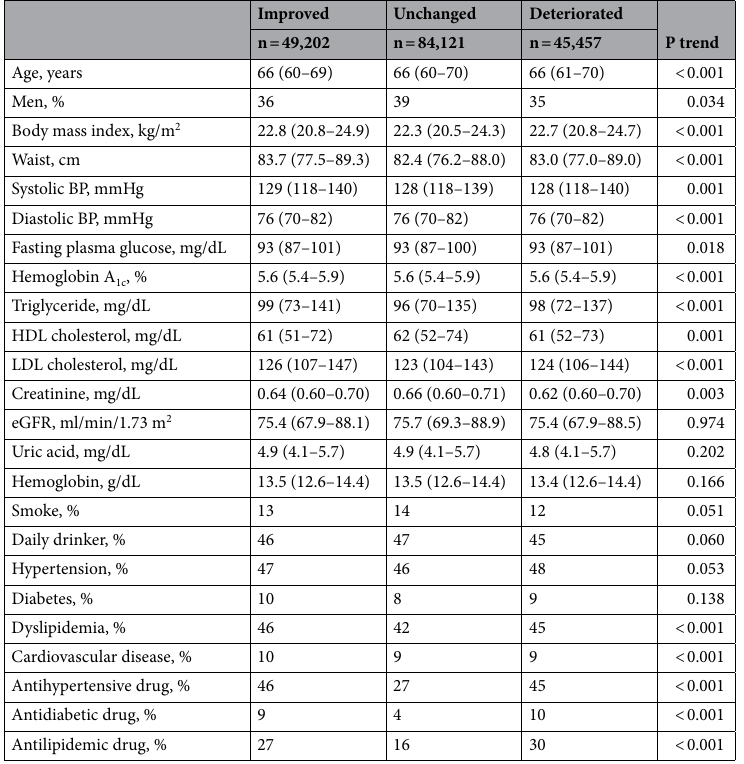
Table 2. Clinical characteristics of 178,780 participants according to stage of change for lifestyle behaviors between two years. Values are expressed as medians (interquartile range), or percentage as appropriate. BP